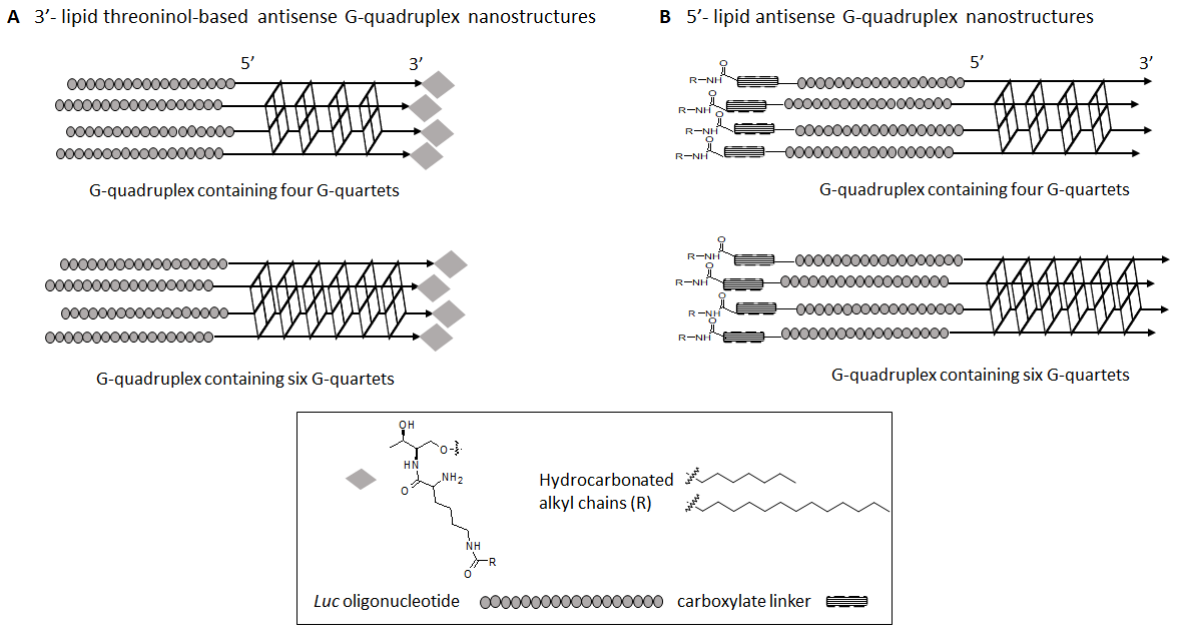
Figure 1. Two series of G-quadruplex forming oligonucleotide conjugates containing four and six G-quartets were engi- neered: ( A ) a threoninol-based building block modified with two lipids of different length (C8 and C14) was introduced covalently at the 3 ′ -termini of a G-rich oligonucleotide sequence and ( B ) two hydrocarbon lipids of different length (C8 and C14) were introduced at the 5 ′ -termini of a G-rich oligonucleotide sequence using a carboxylate linker. An 18-mer phosphorothioate ( Luc ) oligonucleotide was also attached at the 5 ′ -termini of the G-rich sequence oligonucleotide.